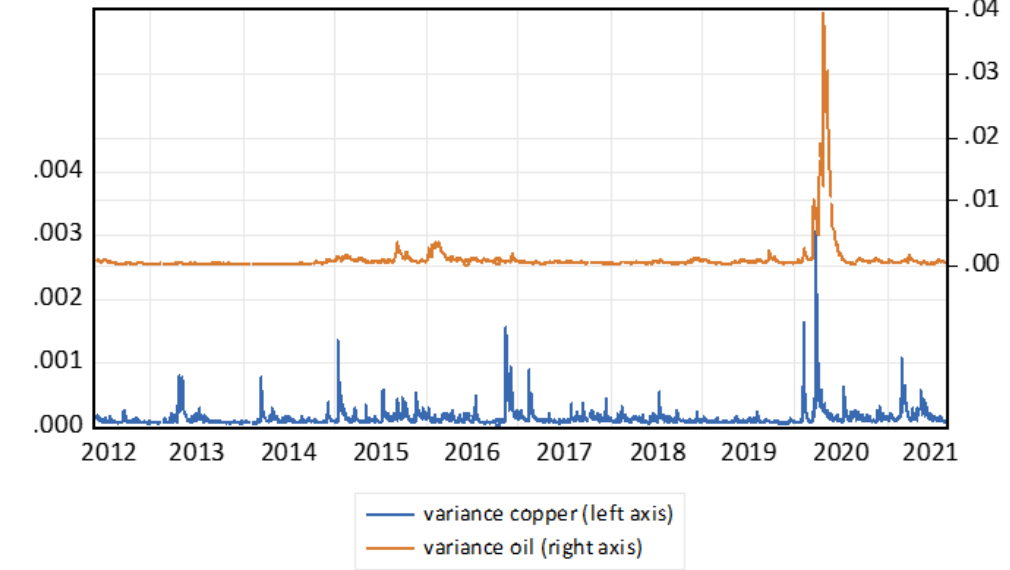
Figure 5. Forecasts for the conditional variance (in-sample) of crude oil and